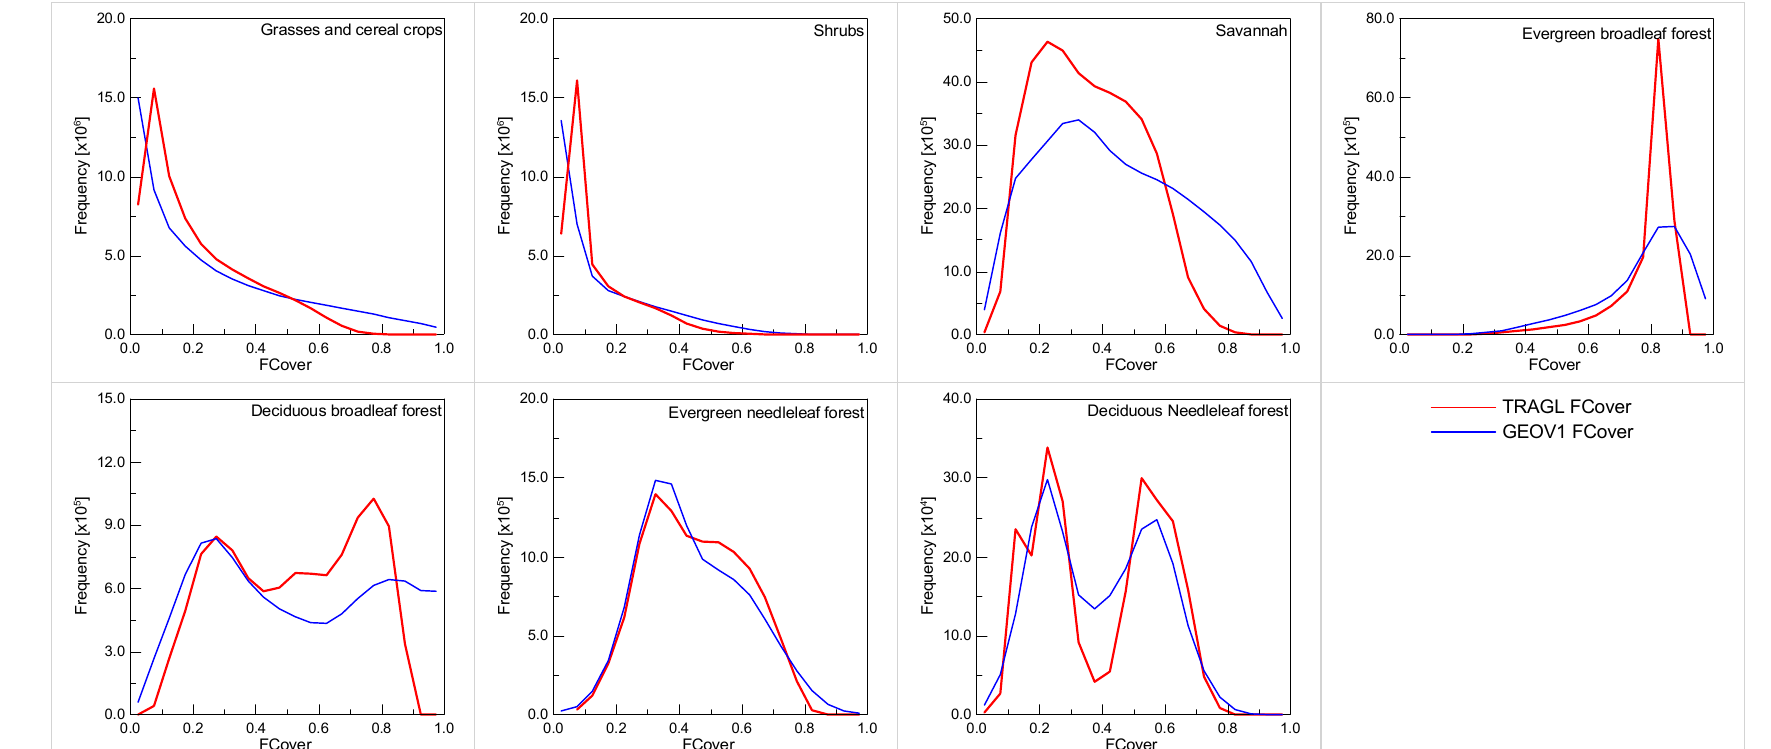
Figure 3 . Histograms of the TRAGL and GEOV1 FCover products for 2001–2005 for different biome types.